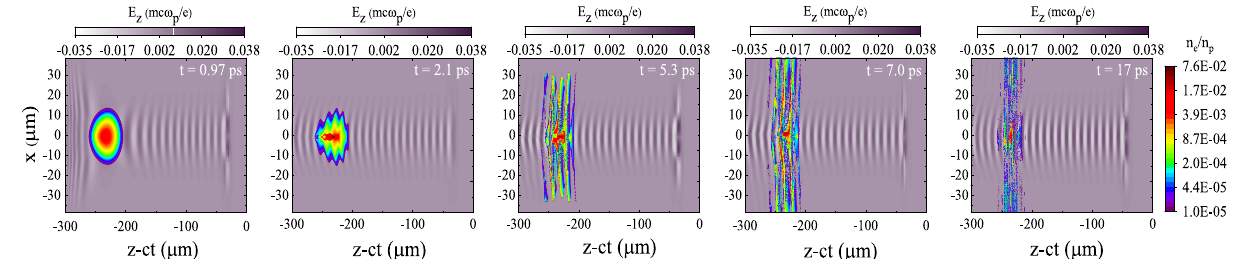
Figure 5. Snapshots showing the accelerating field and the density distribution of the electron bunch with an 3.5 10 16 cm − 3 and an initial energy of 14.8 MeV ( P z 0 / m e c initial peak density of n b0 = × transverse position and the speed of light frame coordinate at different propagation times. The peak amplitude 0.25 . The colorbar of the bunch density is logarithmic. of the laser pulse is a 0 =